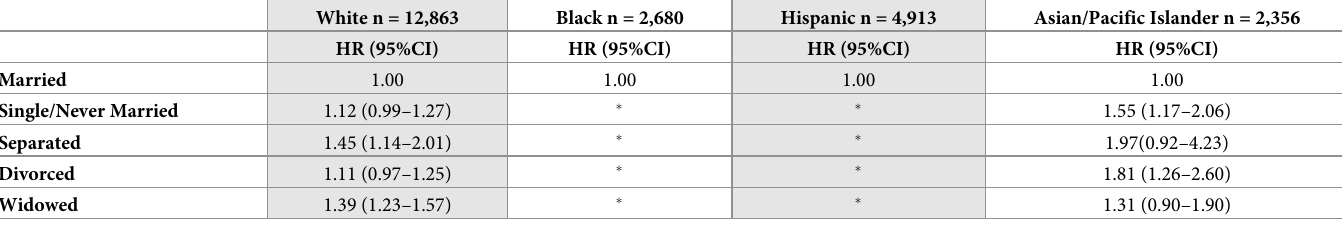
Table 2. Hazard ratios (95%CI) for 22,812 white, black, Hispanic, and Asian/Pacific Islander women with triple negative breast cancer. Hazard ratios are adjusted for age, stage, grade, socioeconomic status, and